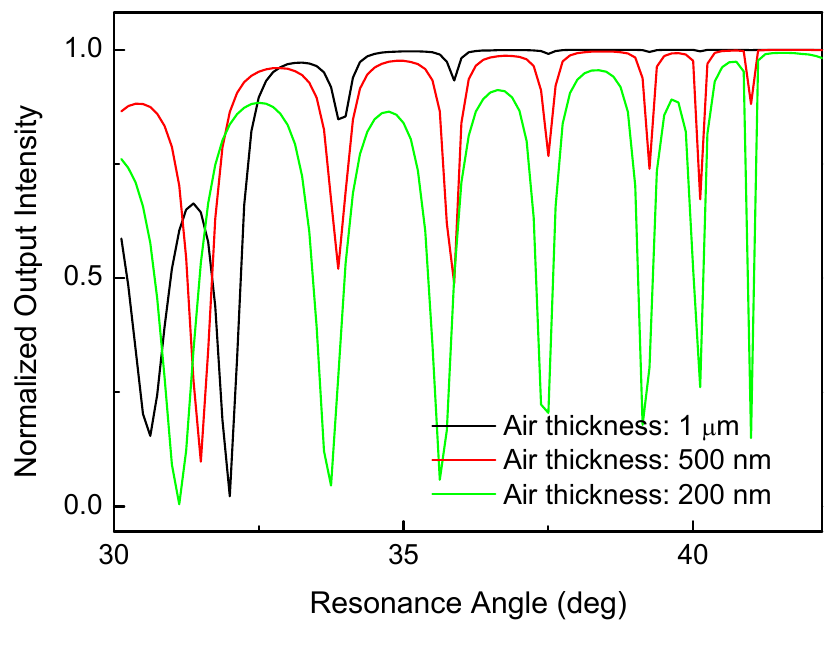
Figure 4. Numerical simulations of RM spectra as a function of the air gap